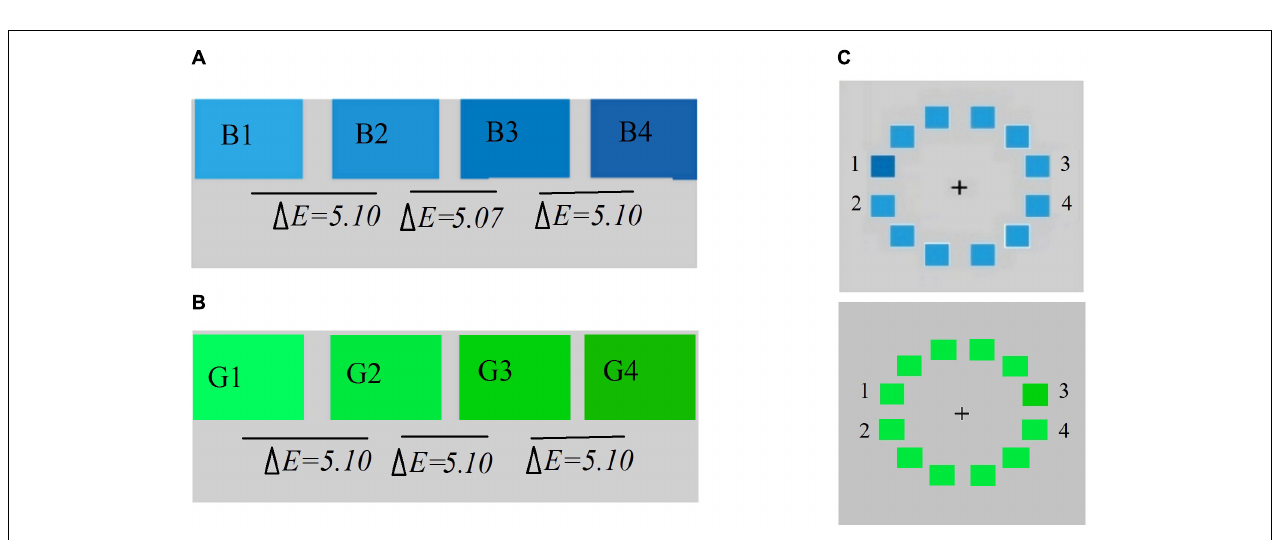
FIGURE 1 | (A) Two-dimensional scaling solution for Mongolian free-sorting of the chagon/qinker/huhe color patches (Stress = 0.015, RSQ > 0.999). (B) Two-dimensional scaling solution for Chinese free-sorting of the Iv/lan color patches (Stress = 0.012, RSQ > 0.999).